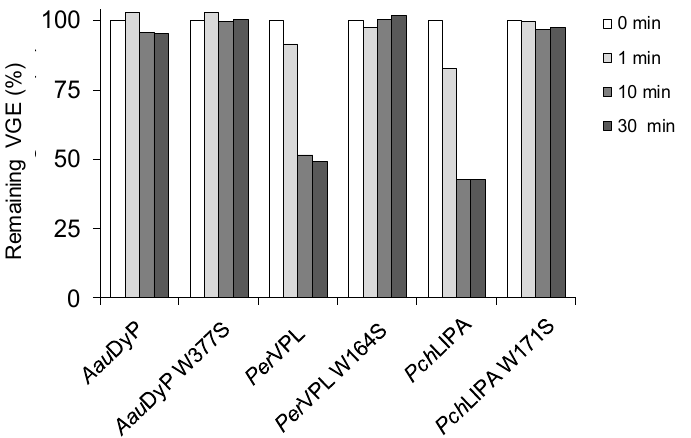
Figure 6. VGE reactions of Aau DyP, Per VPL, and PchLiP A and their tryptophan-less variants. The reactions, including 4.4 µM enzyme and 1 mM VGE in 100 mM tartrate (pH 3), were started by adding 1 mM H 2 O 2 , stopped by sodium-azide addition, and the remaining VGE was quantified at 275 nm after 1, 10 and 30 min and compared with a sample collected before enzyme addition (0